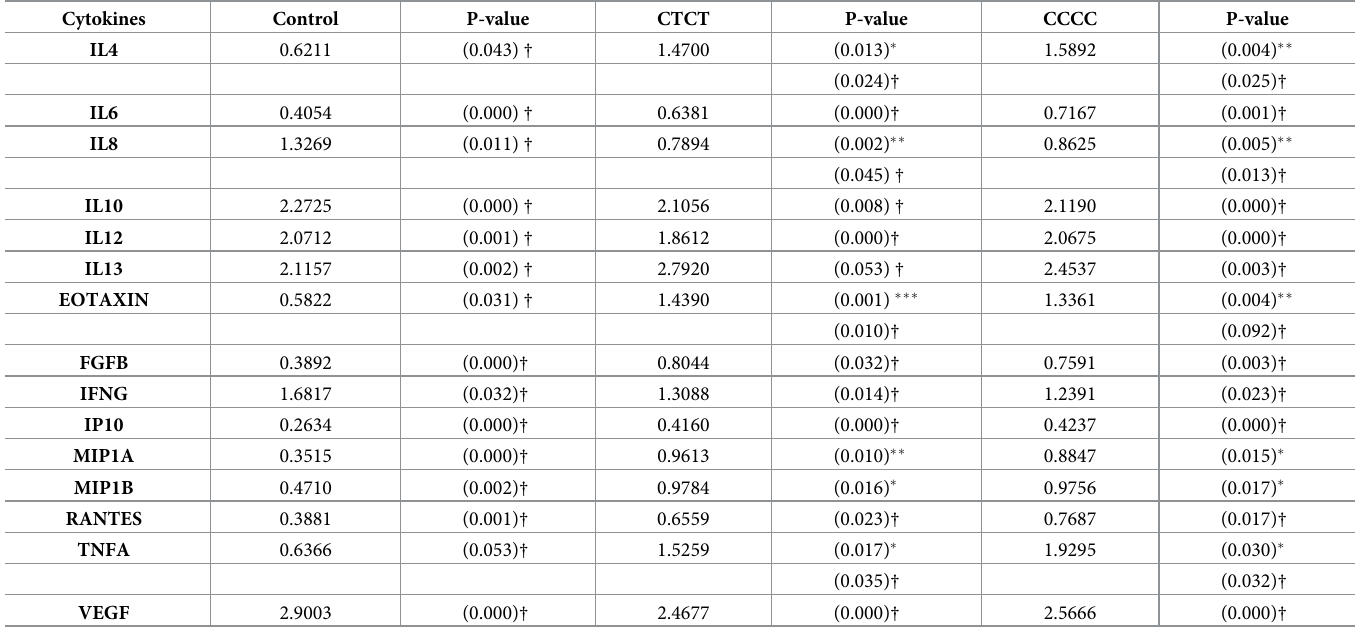
Table 2. Cytokine concentrations after RA treatment in A549 transfected